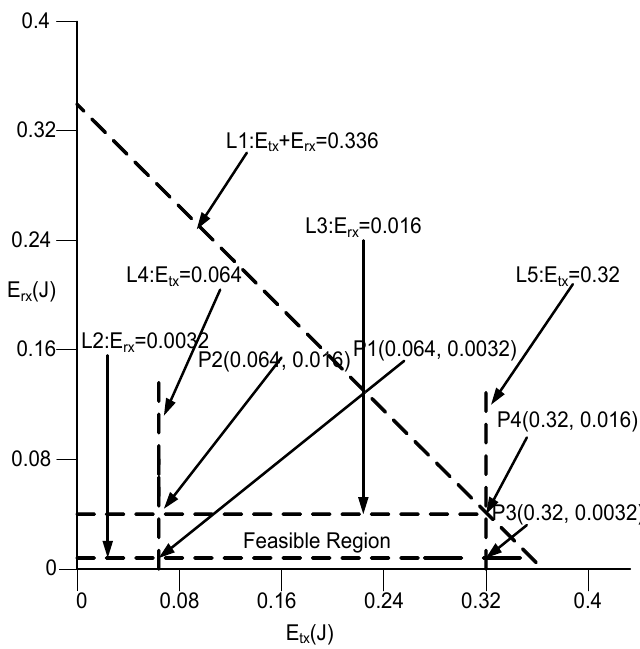
Figure 10. Feasible Region of Energy